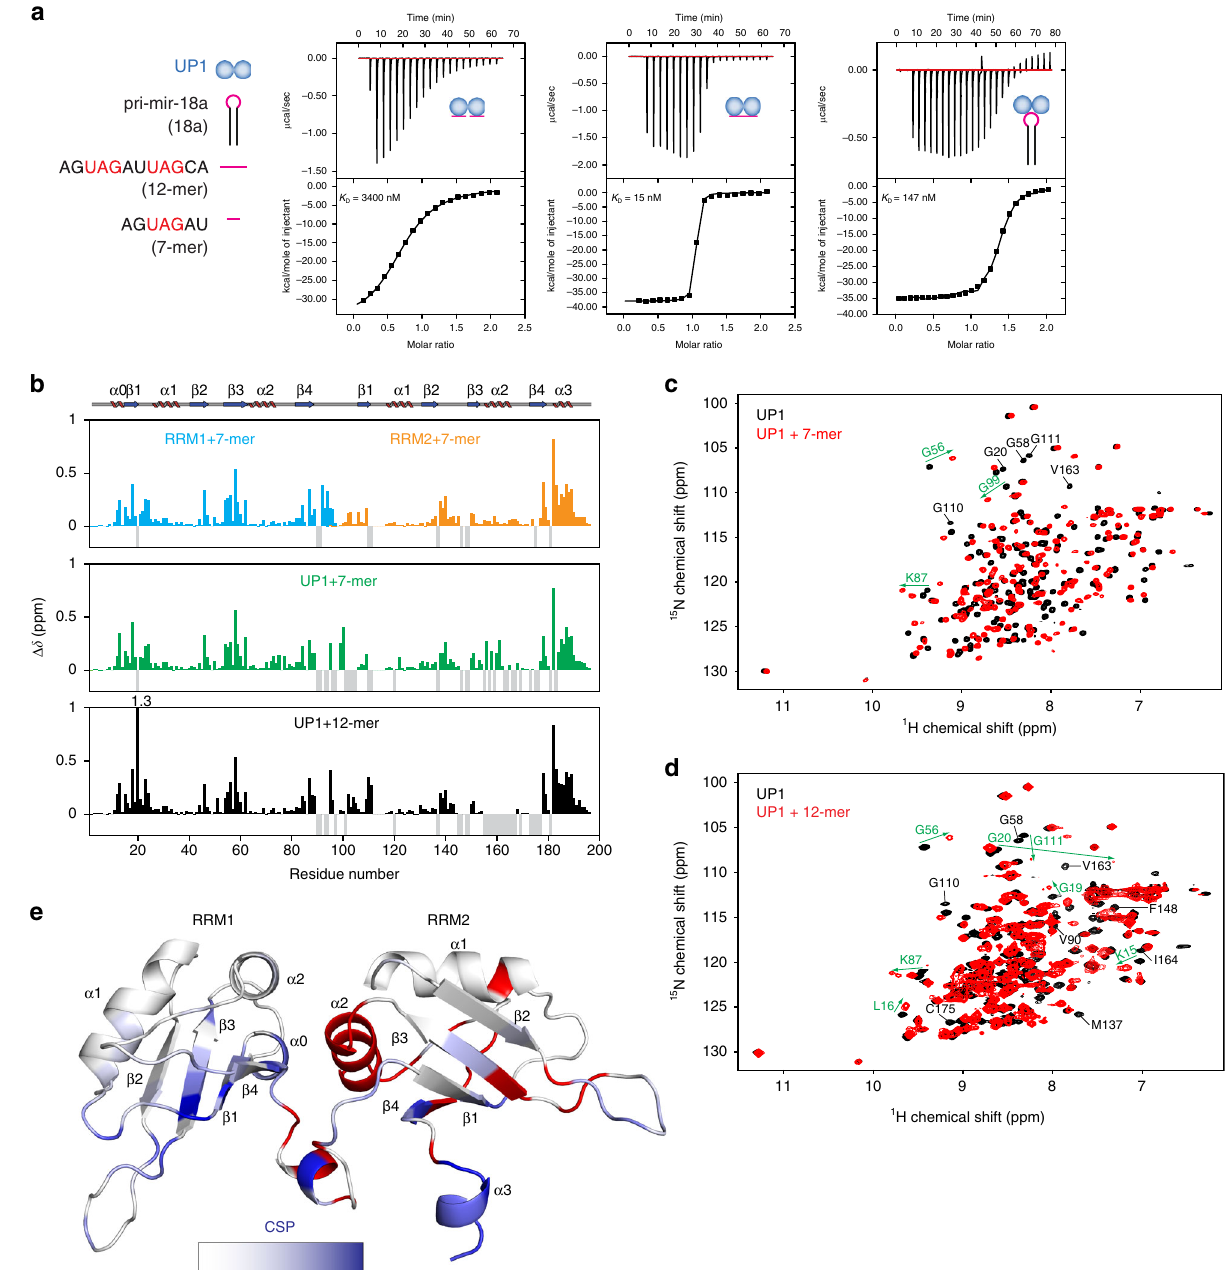
Fig. 2 Biophysical characterization of UP1 – RNA interactions. a ITC of the binding of UP1 to 7-mer, 12-mer, and pri-mir-18a RNAs. K D values are indicated. The sequences of 7-mer and 12-mer oligonucleotides derived from the terminal loop of pri-mir-18a are shown on the left. b Combined 1 H and 15 N chemical shift perturbations (CSPs) of RRM1/7-mer, RRM2/7-mer, UP1/7-mer, and UP1/12-mer are plotted against the residue number. Secondary structure elements are shown above the plot. The gaps in the graph are proline residues; negative gray bars represent residues that could not be assigned due to line-broadening. c , d 1 H, 15 N correlation spectra of UP1, free (black) and in the presence of either the ( c ) 7-mer or ( d ) the 12-mer RNA (red). Selected residues experiencing large chemical shift perturbations and line-broadening upon RNA binding are labeled in green and black, respectively. e The CSPs are mapped onto the structure of UP1 (gradient of white to blue indicates weak to strong CSPs). Residues corresponding to amide signals that are exchange- broadened in the RNA-bound spectra are colored